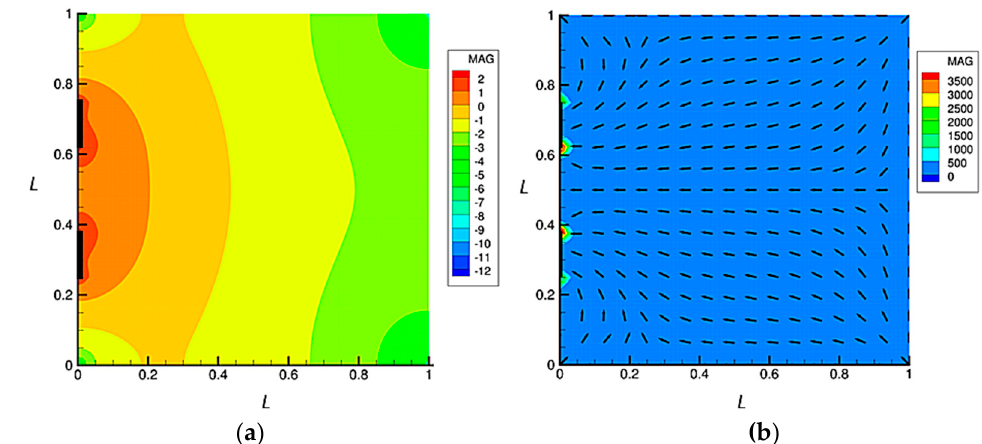
Figure 2. Electric field on the domain midplane ( y = 0.25). ( a ) Isovalues of log| E |. The magnitude of | E | is maximal near the electrode edges. ( b ) Magnitude and direction of ∇ E 2 . The magnitude is shown by isovalues of | ∇ E 2 | and the direction by arrows (the direction of positive DEP force is in this direction and of the negative DEP force in the opposite direction).